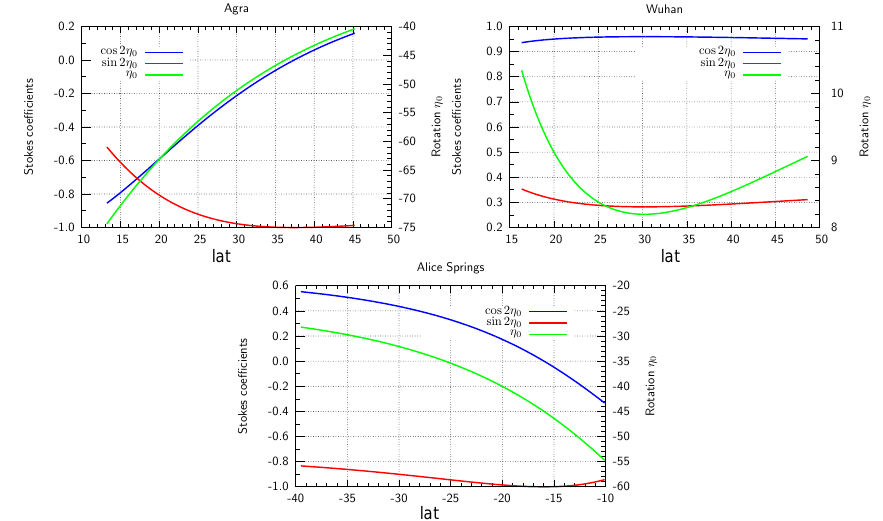
Figure 5. Angle η 0 (right-hand scale) between the reference planes for polarisation used by the radiative transfer code and the geoCARB instrument, shown as a function of latitude along the frames through Agra, Wuhan and Alice Springs. Also plotted are cos2 η 0 and sin2 η 0 (left-hand scale), which are essentially the Stokes coefficients for the simplified model of the instrument (hence the left-hand